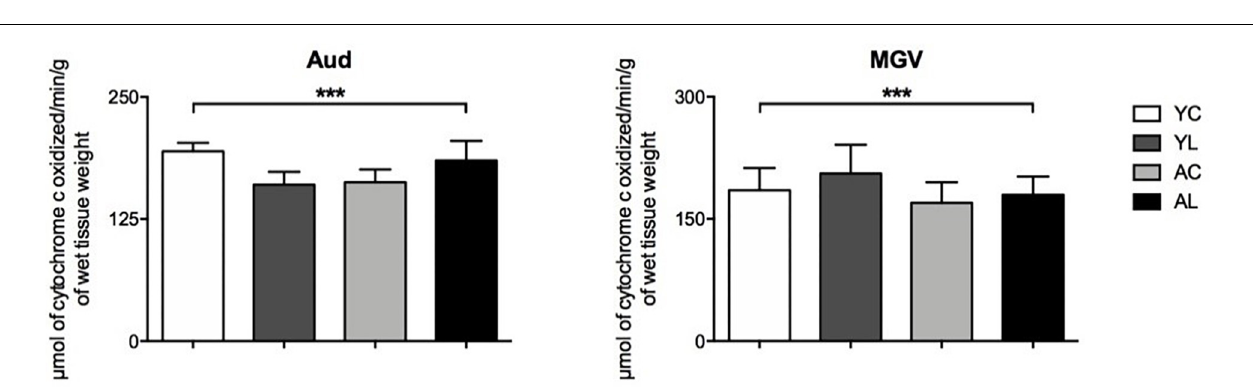
FIGURE 4 | Limbic system. Significant CCO activity group differences in the CA1, mt, and AD in rats from young laser (YL; n = 5), young control (YC; n = 7), aged laser (AL; n = 6) and aged control (AC; n = 6) groups ( p < 0.05; ANCOVA). (*) One main effect in the CA1 and AD. (***) Interactions of age and treatment in the mt. See text for details.